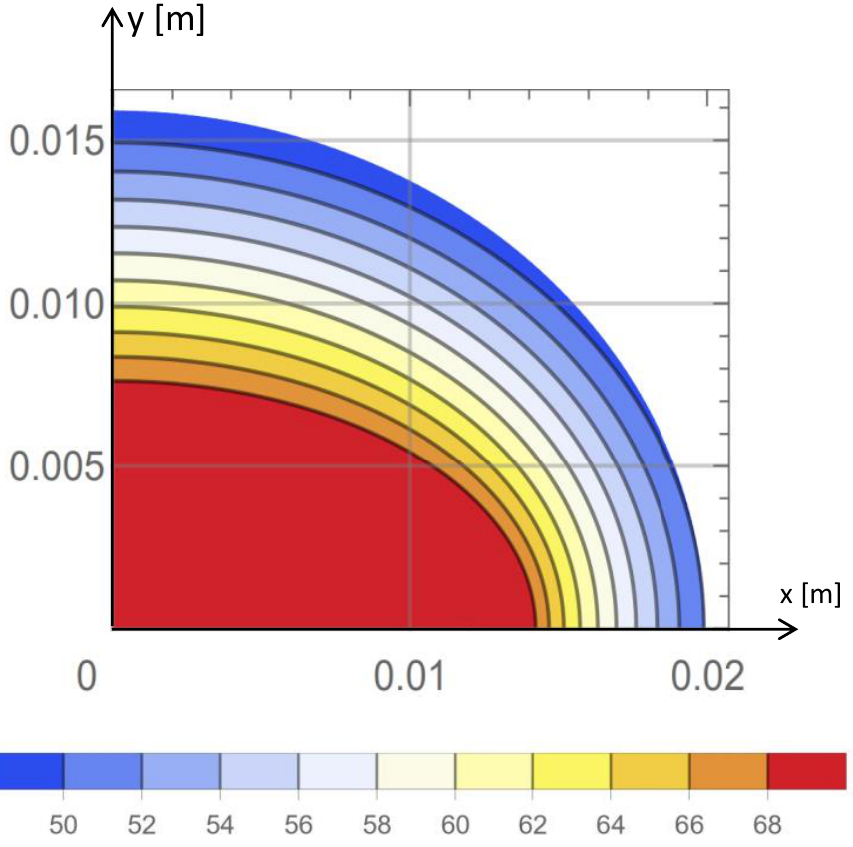
Figure 4. Temperature field distribution in the first quarter of the cross-section of the elliptical conductor (for I cr = 553.51 A ).